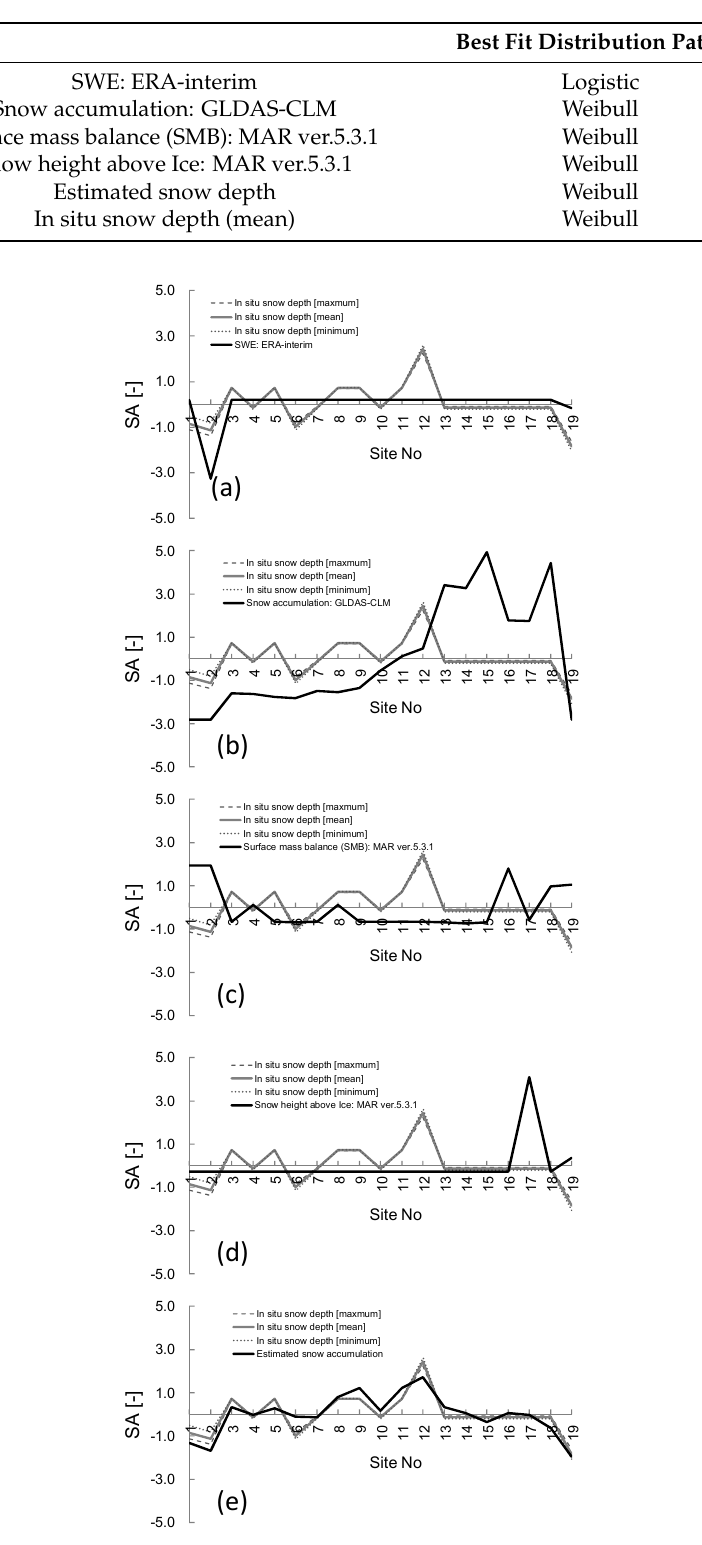
Figure 15. Standardized anomaly (SA) index for various in situ snow depth products (maximum, mean, and minimum values), ( a ) SWE in ERA-interim, ( b ) snow accumulation in GLDAS-CLM, ( c ) SMB in MAR ver. 5.3.1, ( d ) snow height above ice in MAR ver. 5.3.1; and ( e ) estimated snow depth in this study.